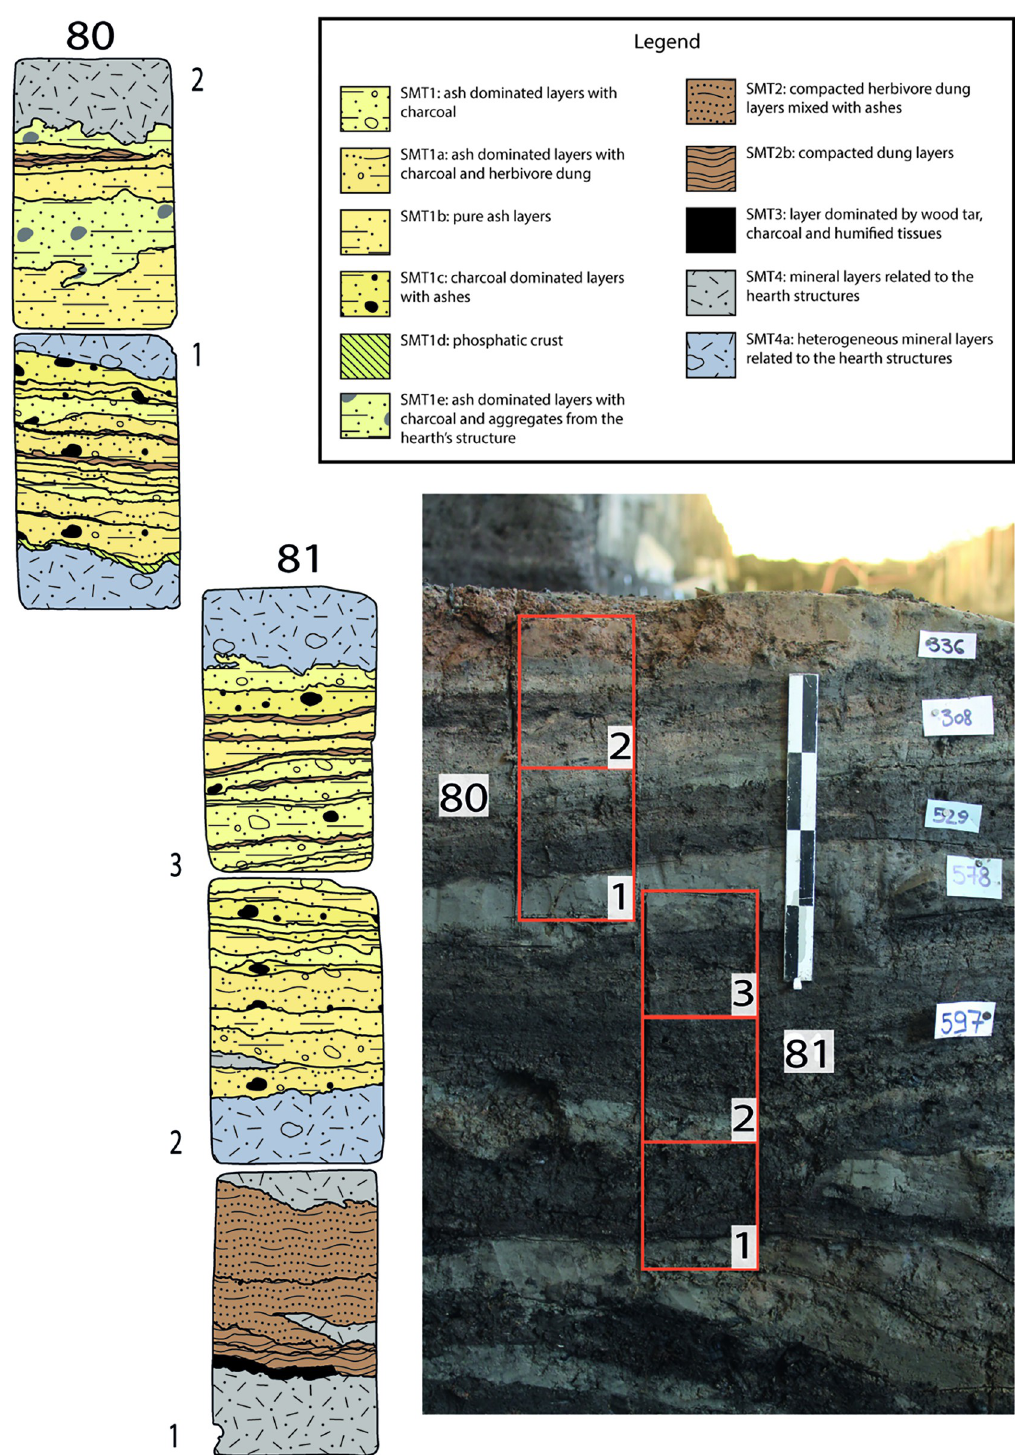
Fig 12. Sampling location of OPP 80–81 and interpretation of the vertical accretion of structure E. Right: detail of Fig 5C, showing the position of monoliths OPP 80 and 81. Two thin sections were obtained from OPP 80 (80–1, 80–2), while monolith OPP 81 provided three thin sections (81–1, 81–2, 81–3). Left: interpretation of the thin sections, with a SMT assigned to each sub-unit.